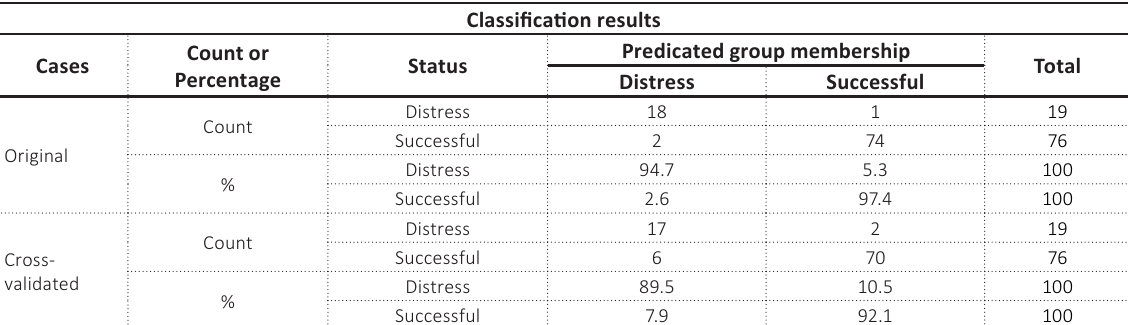
Table 6. Classification statistics